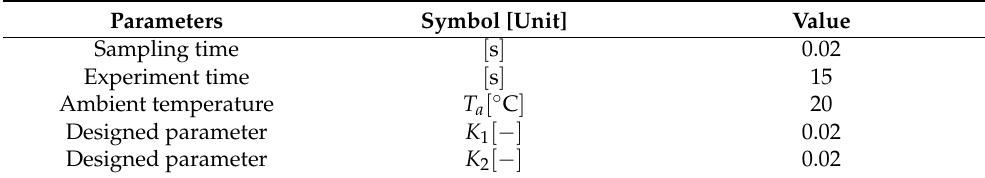
Table 2. Experimental